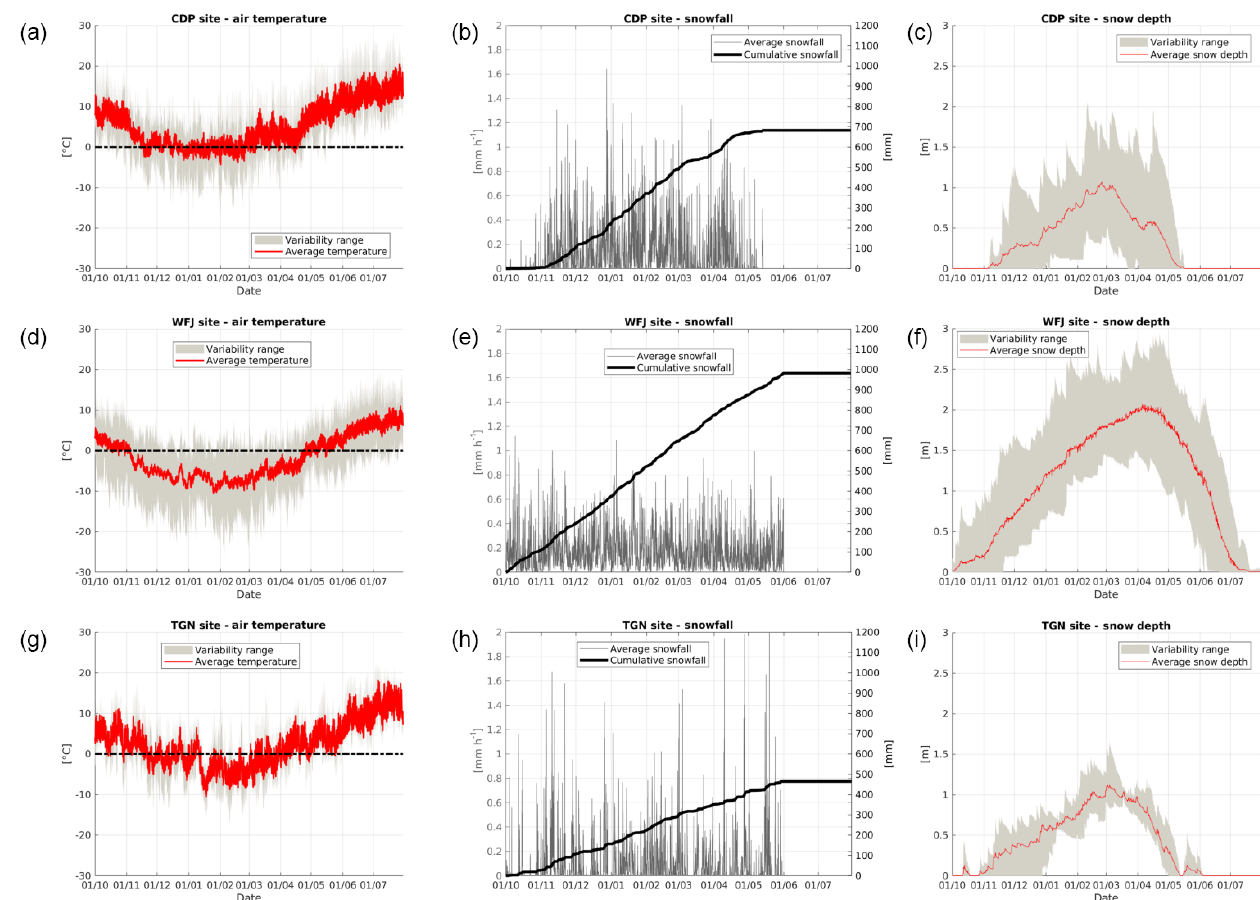
Figure 1. Meteorological characterization of the CDP site (a, b, c) , WFJ site (d, e, f) , and TGN site (g, h, i) – Air temperature (a, d, g) , snowfall rates ( b, e, h ; at WFJ and TGN sites snowfall rates have been estimated according to Froidurot et al., 2014), and snow depth (c, f, i) throughout an average snow season (early October–early July) throughout the overall